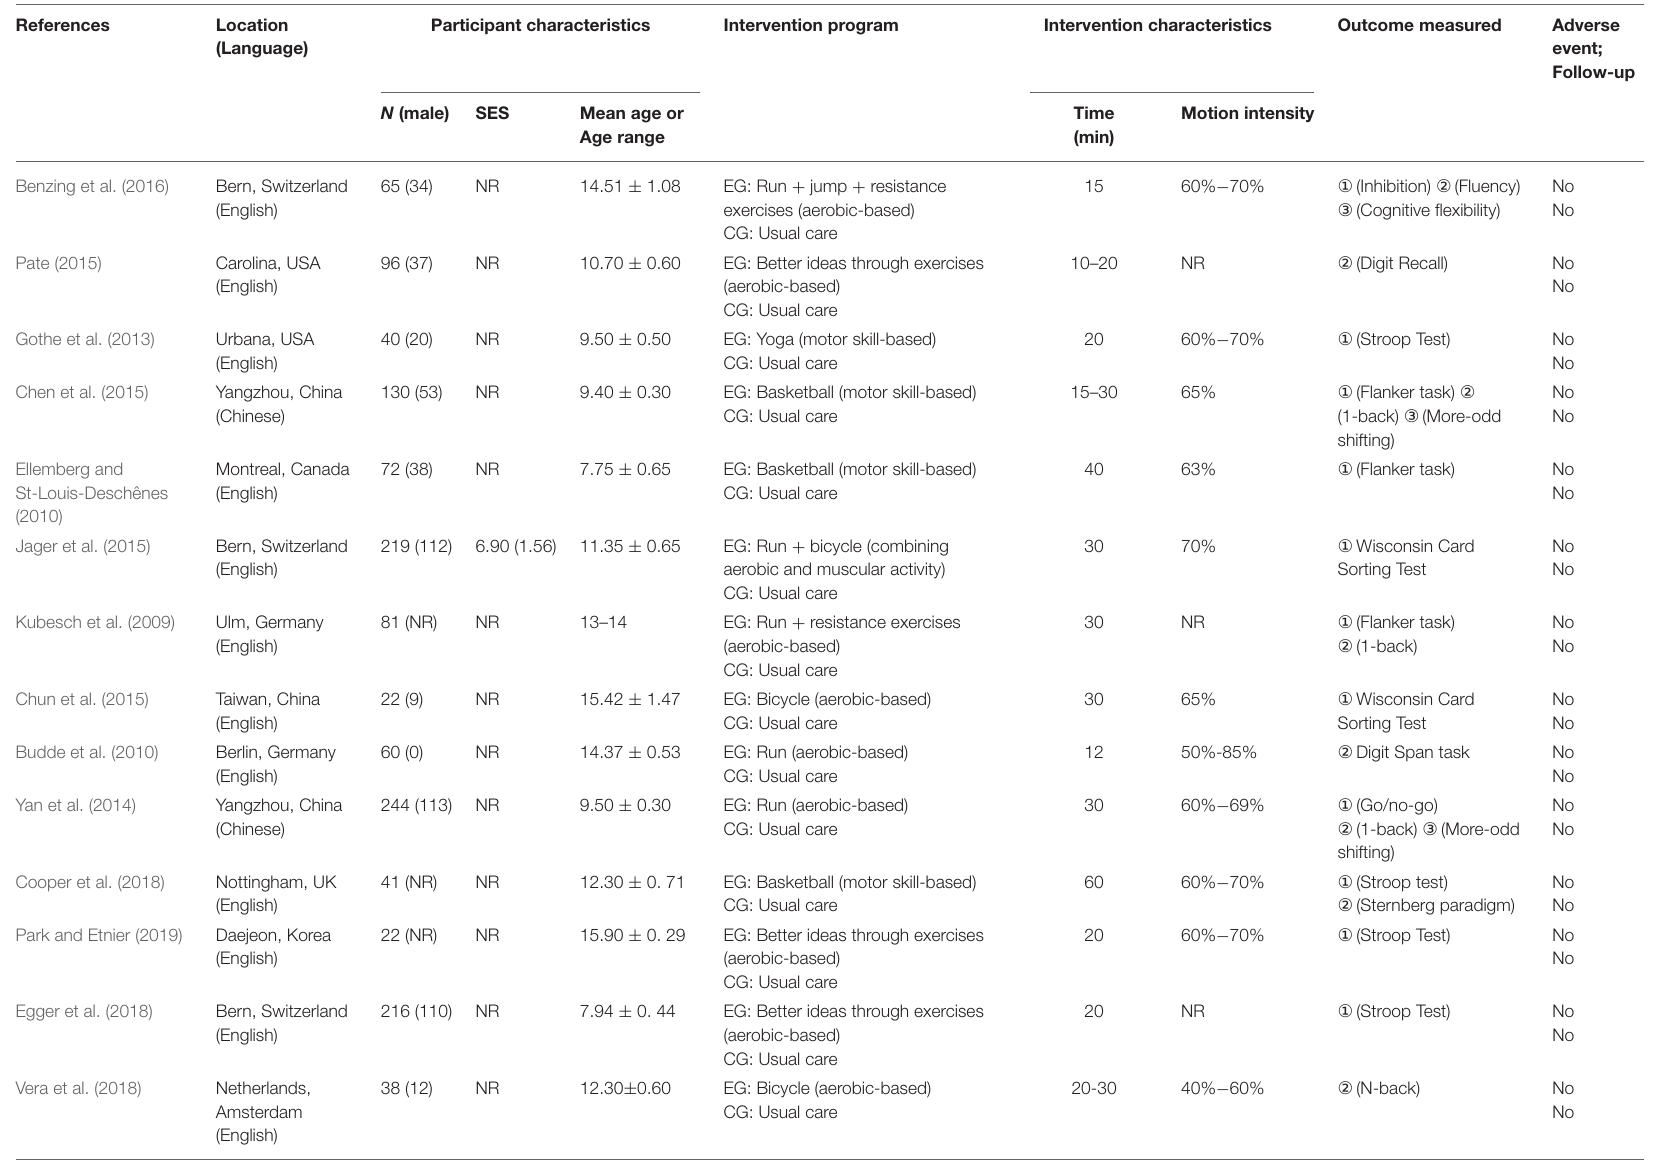
TABLE 1 | Characteristics of the studies included in the meta-analysis (acute